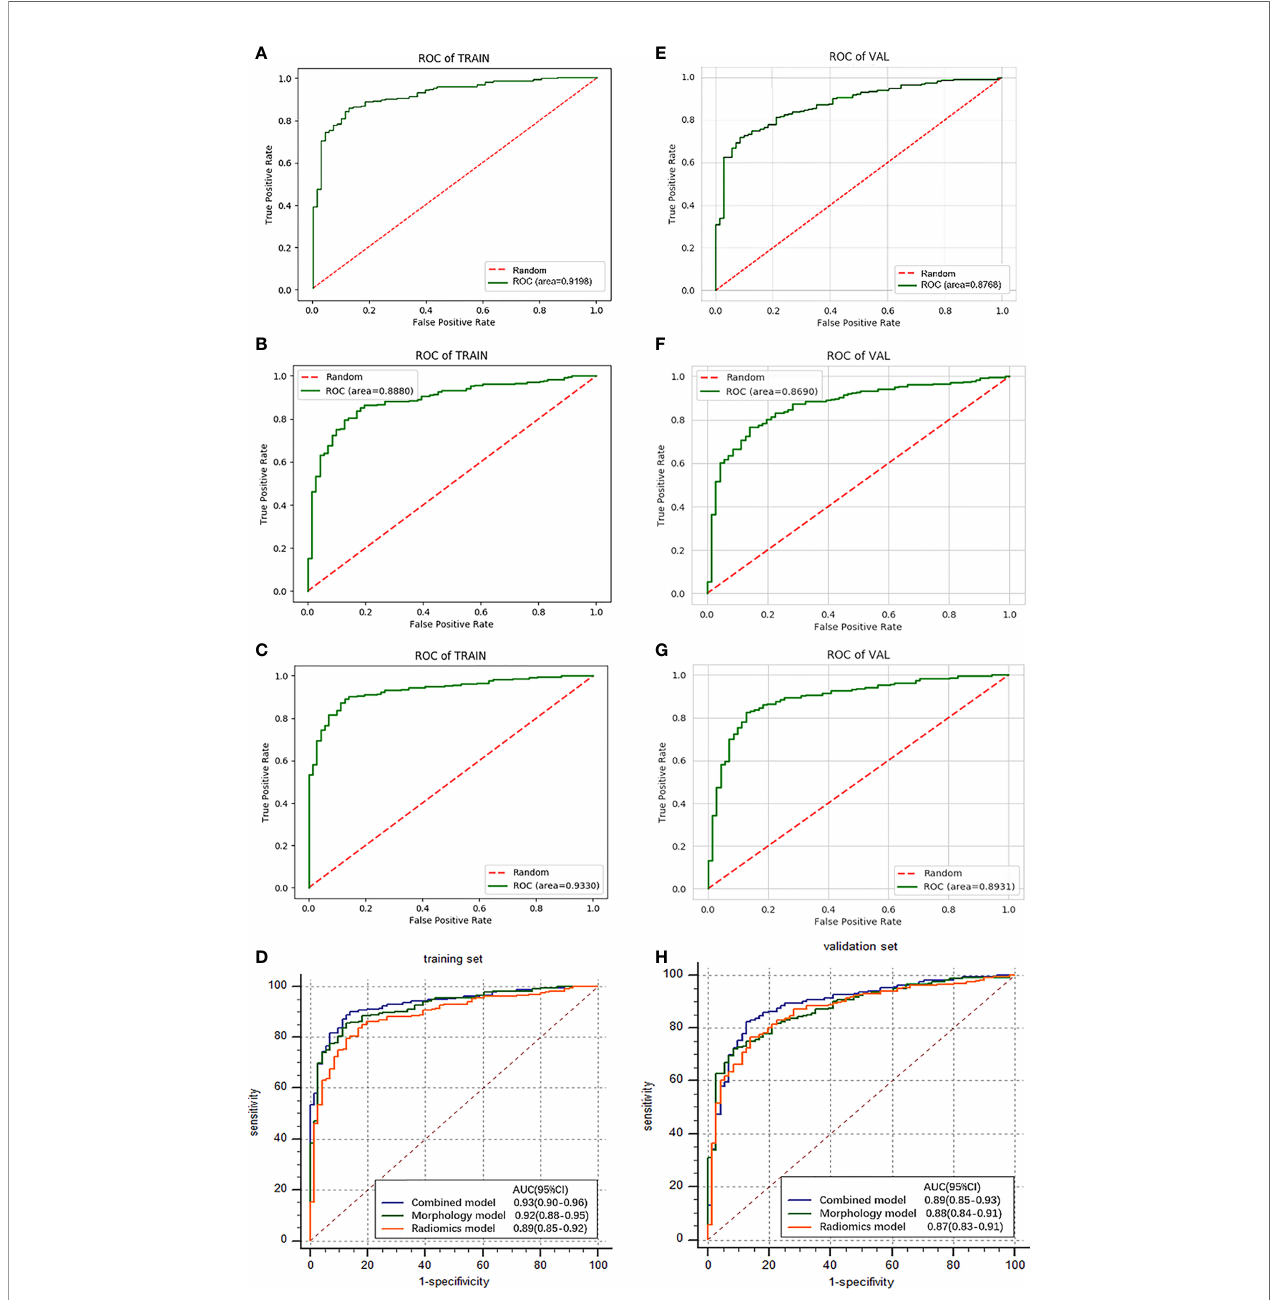
FIGURE 4 | Results and comparison (D, H) of ROC curve analysis. The ROC curves for morphological model (A) , radiomics model (B) , and combined model (C) in the training cohorts. The ROC curves for morphological model (E) , radiomics model (F) , and combined model (G) in the validation cohorts.